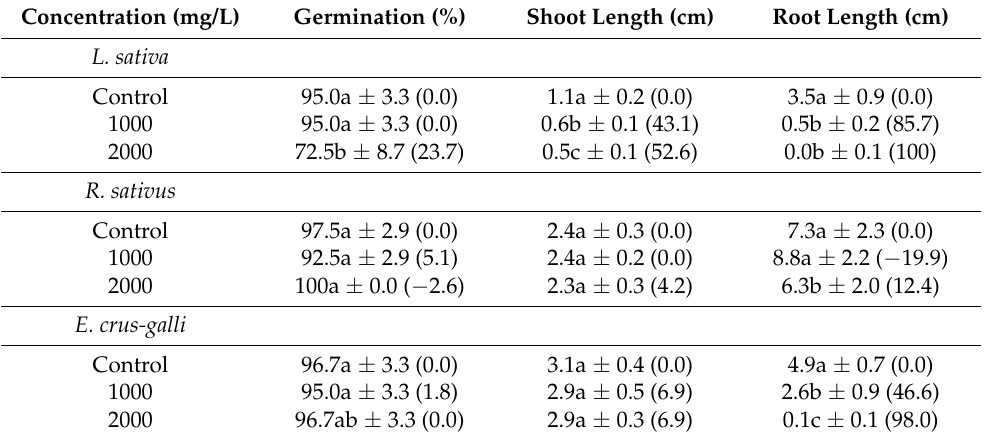
Table 3. Effects of C. crenata ethyl acetate extract on germinations and growth of R. sativus , L. sativa , and E.